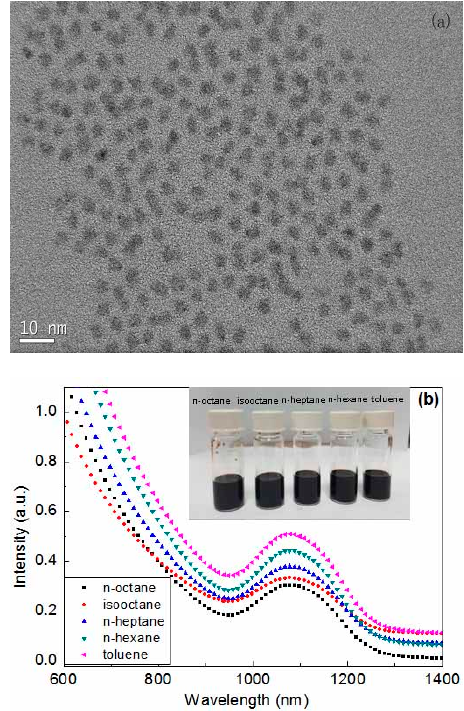
Figure 1. ( a ) TEM image of as prepared PbS CQDs ( b ) UV-absorption spectra of PbS CQDs in different solvents. CQD = colloidal quantum dots.